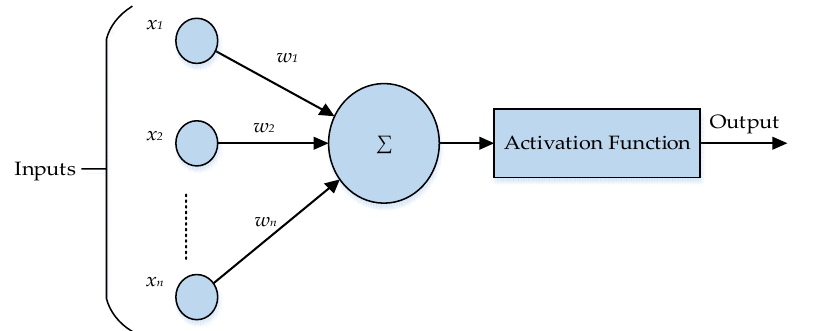
Figure 6. 1-perceptron ANN.